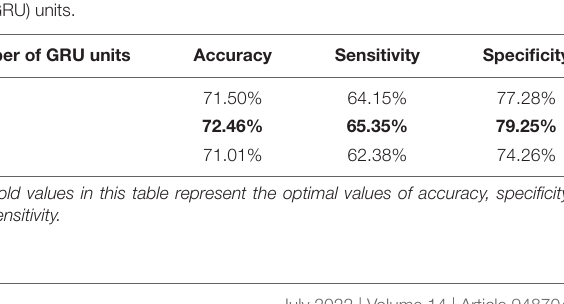
Frontiers in Aging Neuroscience |